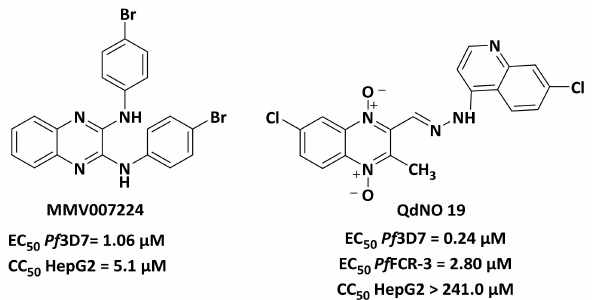
Figure 2. Structures of quinoxalines with antiplasmodial